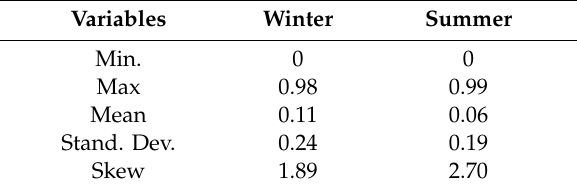
Figure 13. Maximum outflow discharge (MO) in the spillway during flood dam routing. Table 11. Basic statistics for the η coe ffi